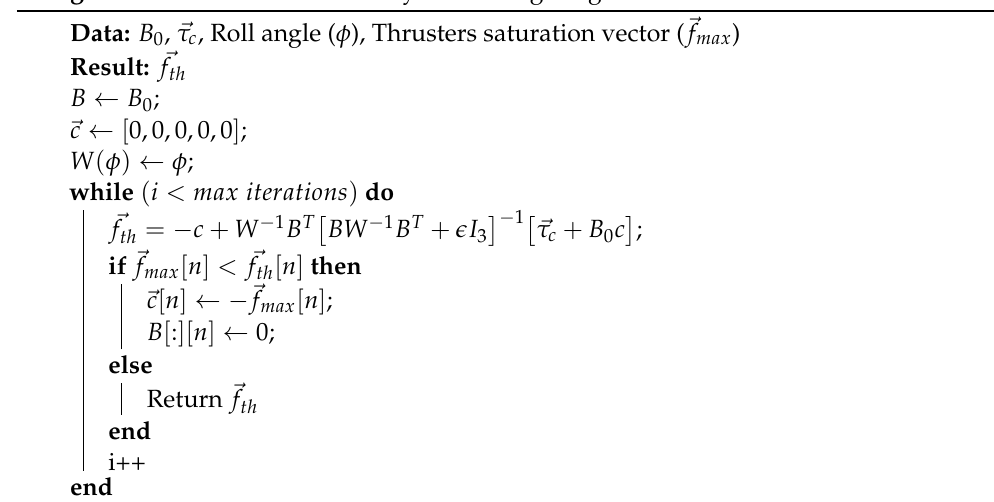
Algorithm 1: RPI method with dynamic weighting